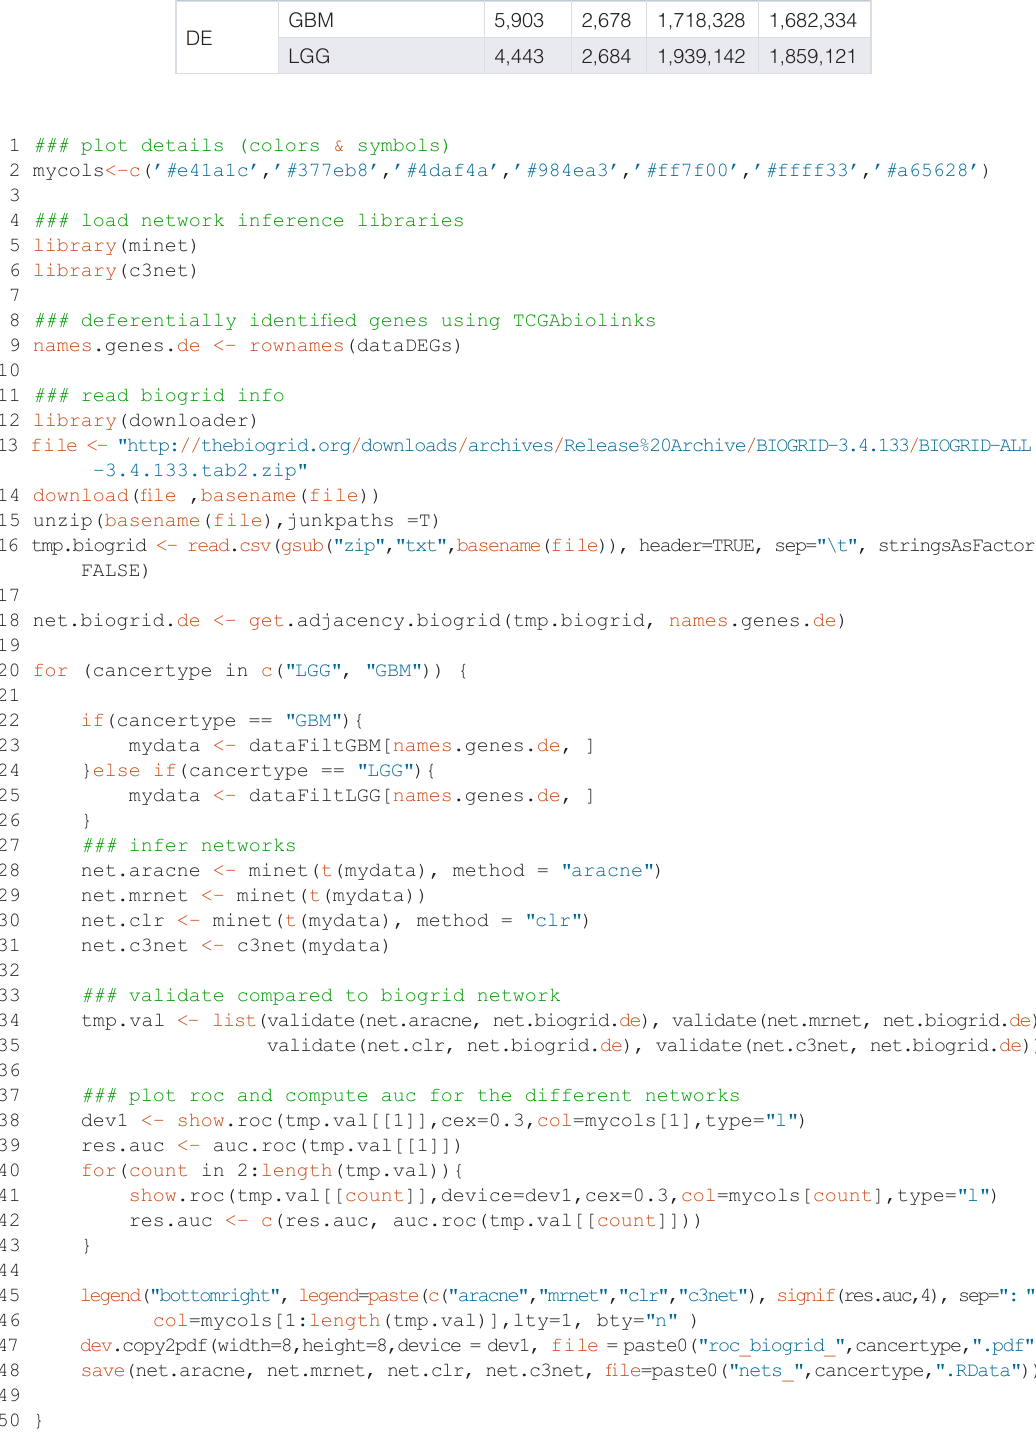
Table 3. Number of edges in the inferred gene regulatory networks; first two lines: networks inferred using 2,901 differentially expressed genes. gene set inference algorithm aracne c3net